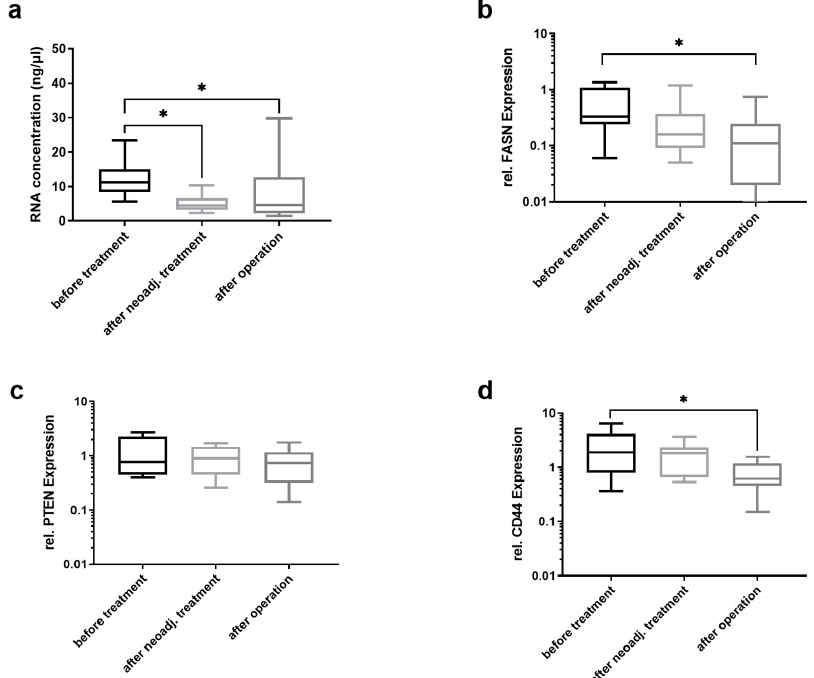
Figure 5. FASN, PTEN, and CD44d mRNA levels after neoadjuvant chemotherapy and curatively intended gastrectomy. In twelve patients, ( a ) the total RNA amount and the relative mRNA levels of ( b ) FASN, ( c ) PTEN, and ( d ) CD44 from EVs were measured using a Nanodrop device and by qRT-PCR. The total RNA amount and the relative mRNA levels of FASN decreased after neadjuvant therapy, and CD44 mRNA levels decreased after neodjuvant therapy as well as at 10 days post-surgery. Kruskal–Wallis test with Dunn’s multiple comparisons test was used to analyze the differences between the different time points ( n = 11; * = p <